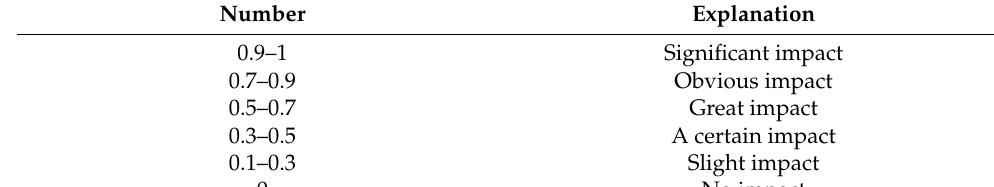
Figure 3. Influence diagram with the number of events and the number of estimates needed. Table 1. Score table.